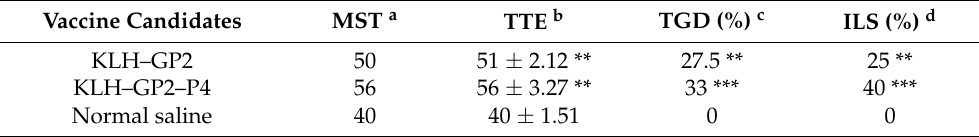
Figure 6. Preventive effects of peptides vaccination against a TUBO tumor in BALB/c mice model. The tumor-bearing mice ( n = 6) were pre-vaccinated with either KLH–GP2–P4 and KLH–GP2. Mice were examined for ( A ) tumour growth and ( B ) variations in survival. The data are presented as the mean ± SEM. **** p < 0.0001, ** p < 0.01 and * p < 0.05, indicates significant difference as compared to normal saline group. Table 1. Prophylactic efficacy of different vaccine formulations used against a TUBO breast tumor in the BALB/c mice model.